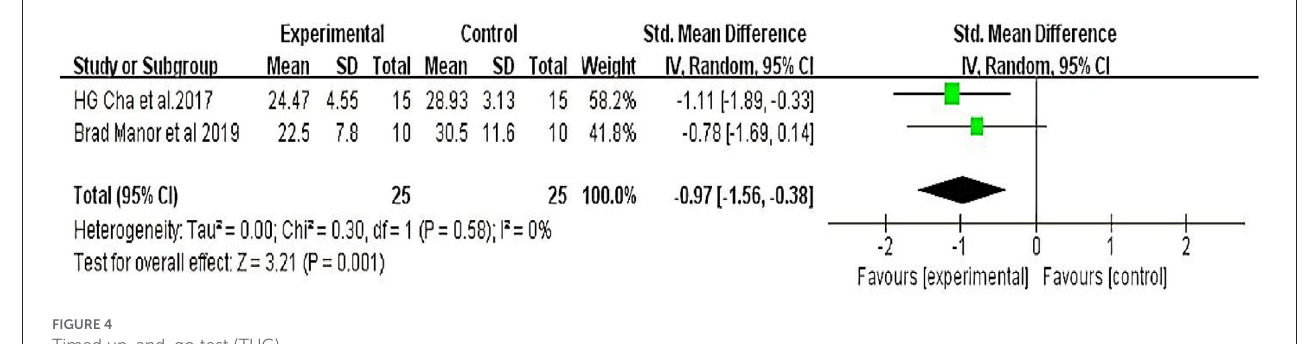
FIGURE4 Timed up-and-go test